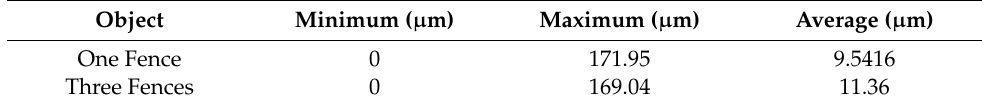
Table 5. Stress Values for an Angular Load of 100